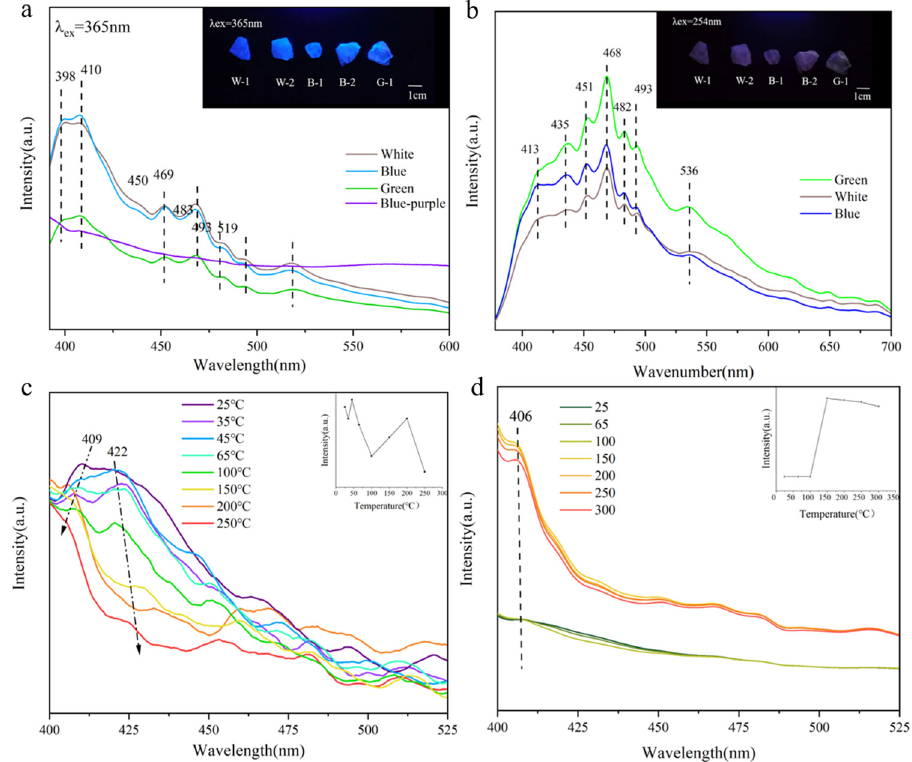
Figure 7. ( a ) Emission spectrum of samples at 365 nm; ( b ) Emission spectrum of samples at 254 nm; ( c ) Emission spectrum of white fluorite at an excitation wavelength of 365 nm at 25 °C–250 °C; ( d ) Emission spectrum of color-changing fluorite at an excitation wavelength of 365 nm at 25 °C–300 °C. Table 2. The fluorescent properties of the four types of fluorite samples. Color Emission Lines